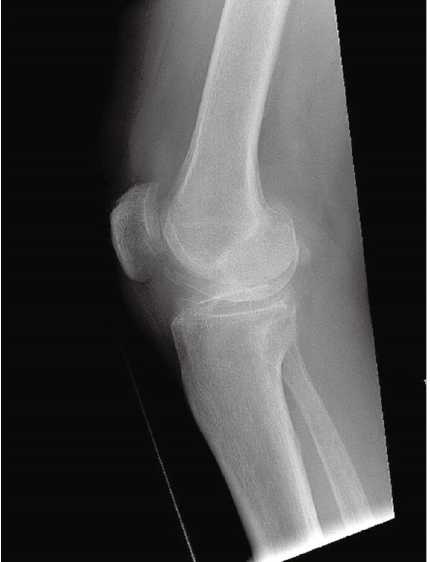
Figure 3: Preoperative radiographs showing the lateral view of the right